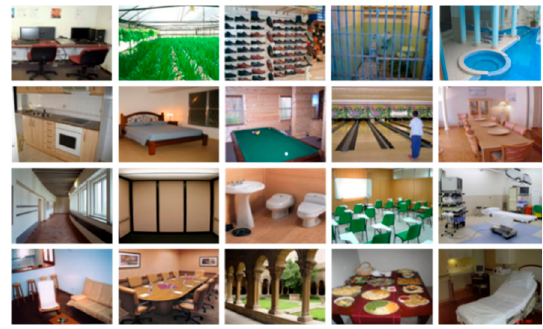
Figure 15. Example images from the CVPR 67 indoor scene dataset.